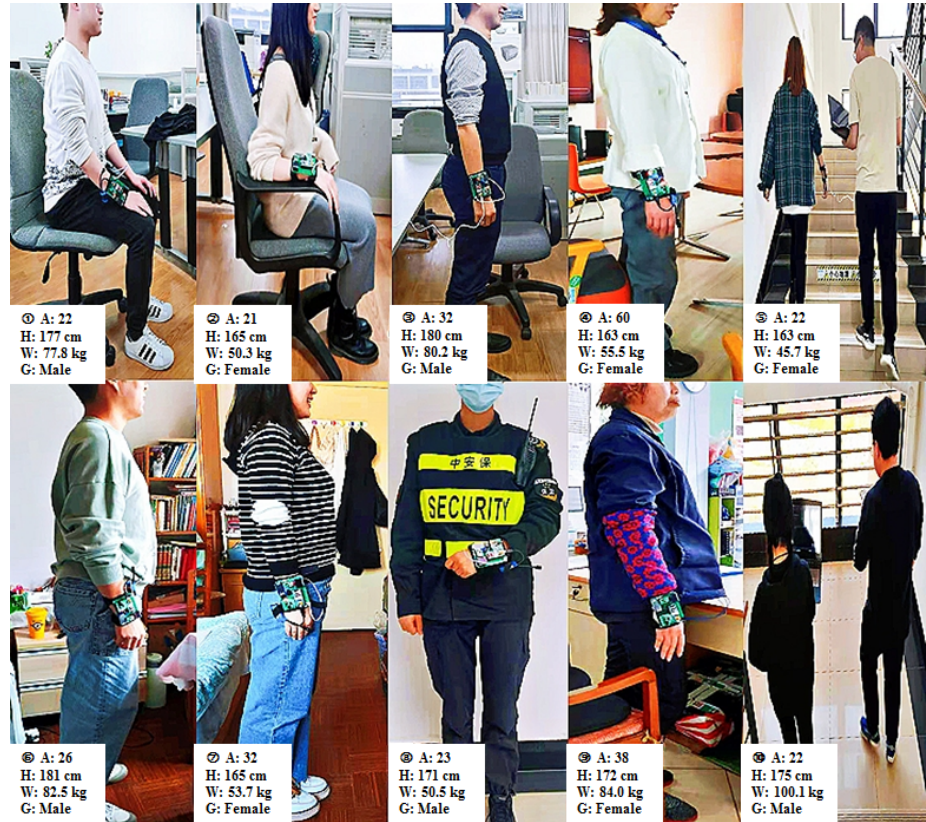
Figure 3. The 10 participants wore wearable sensors to conduct different activity recognition experi- ments. (A, H, W and G are the abbreviations of age, height, weight and